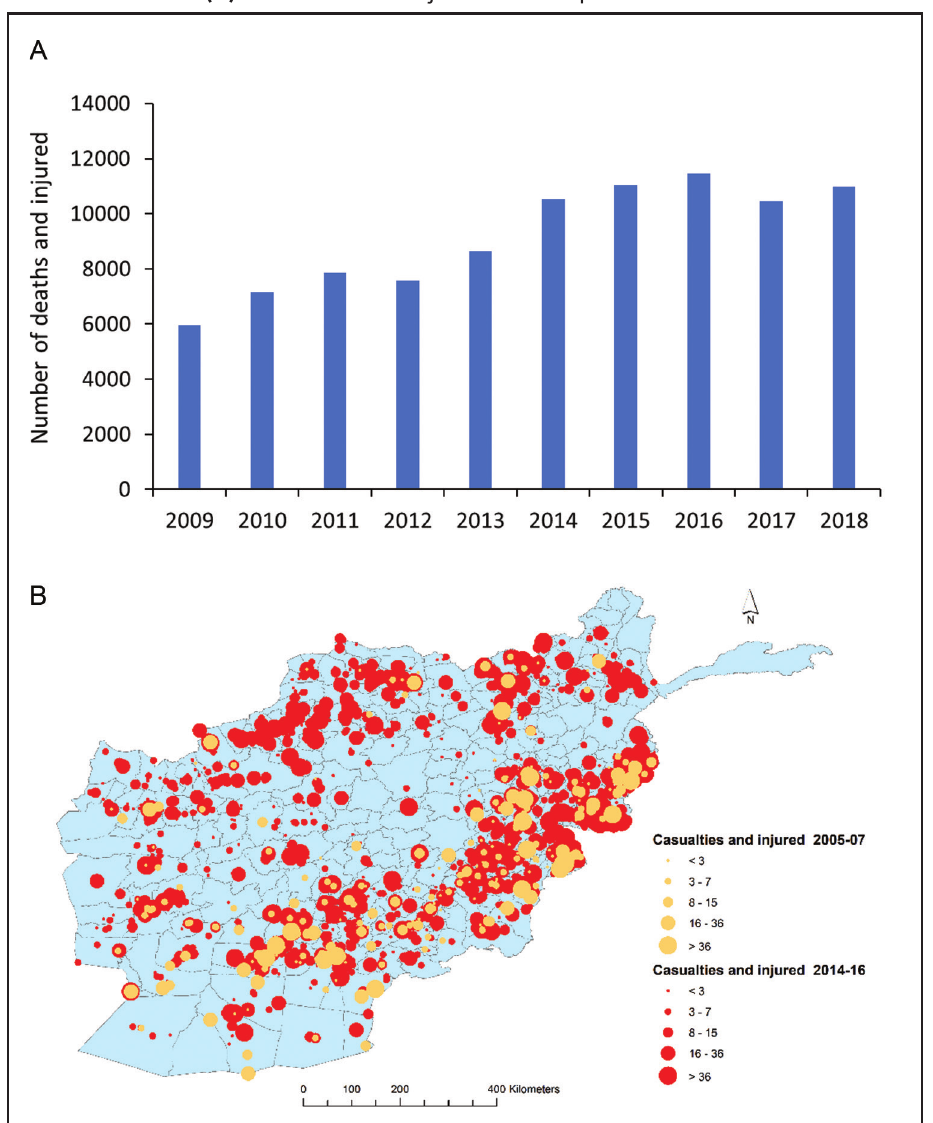
Figure 1 Conflict-related casualties and injured in Afghanistan. (A) Casualties and injured over time. (B) Casualties and injured across